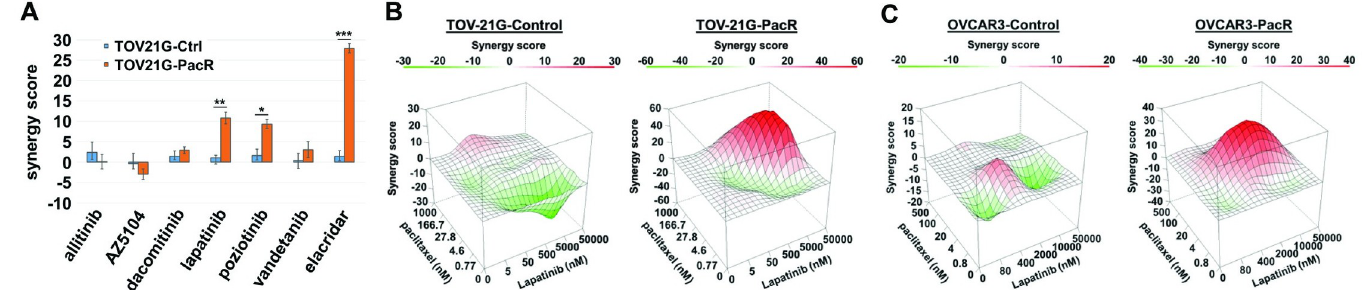
Fig 3. Lapatinib and poziotinib demonstrate anti-proliferative synergy when combined with paclitaxel. (A) A panel of TKIs were screened for anti-proliferative synergy when combined with paclitaxel on TOV-21G-control and–PacR derivative cell lines. The ABCB1-specific inhibitor, elacridar, was included as a positive control. Average Bliss synergy scores across drug combinations (minimum of 3 independent experiments) are summarized as averages +/- standard error of the mean. Unpaired two-tailed t-tests were performed for each drug (control vs. PacR; � p < 0.05; �� p < 0.005; ��� p < 0.0005). (B) Representative surface response model plots of synergy analyses using a Bliss independence model for paclitaxel in combination with lapatinib are depicted for control and PacR TOV-21G and (C) OVCAR3 cell lines.